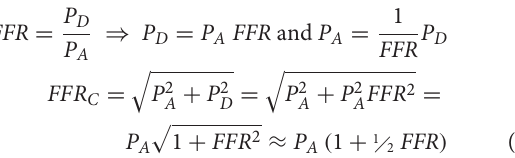
) and increases (see FFR ), if the change in P D is ↓ ↑